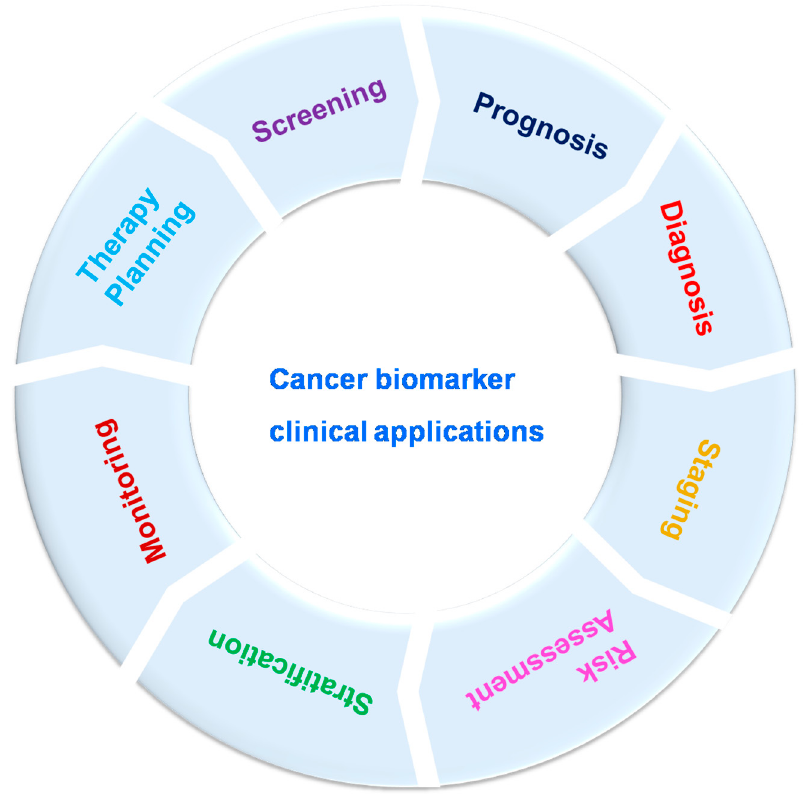
Figure 2. Cancer biomarker clinical applications.